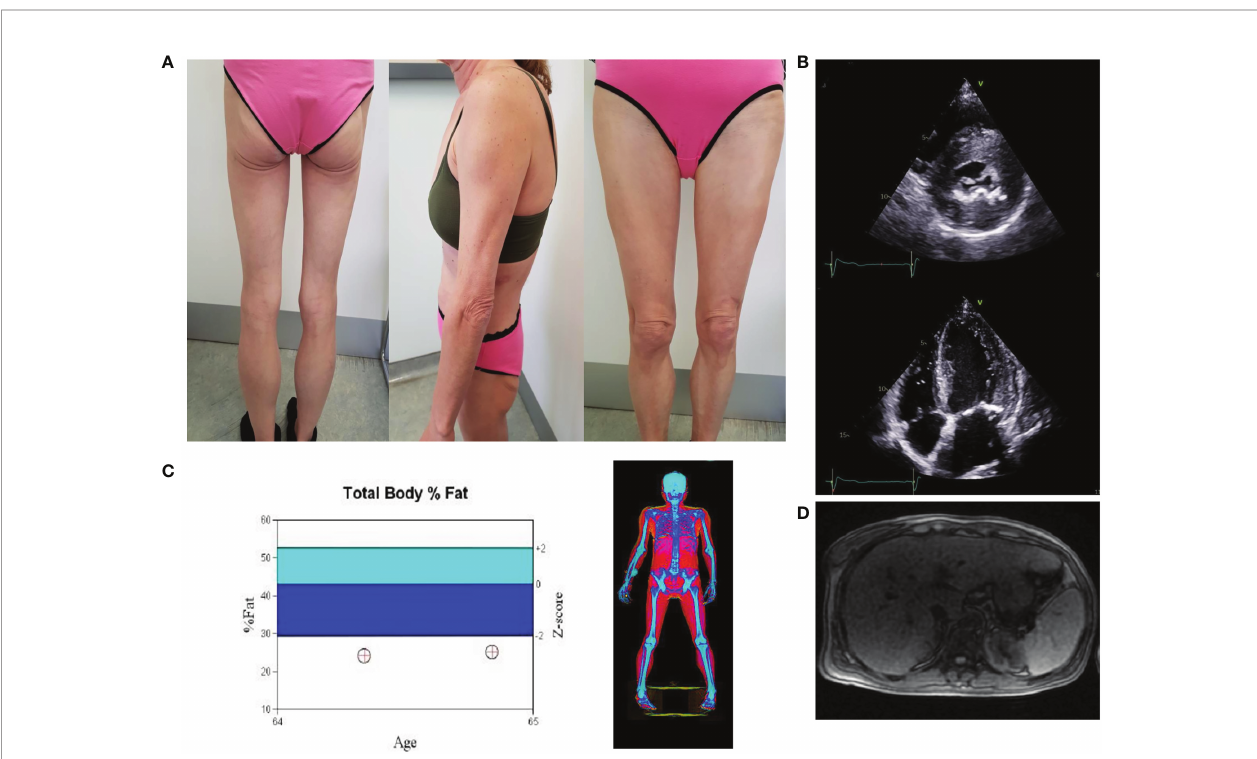
FIGURE 1 | (A) Total lipoatrophy of extremities and gluteal area, (B) Two dimensional echocardiography revealed left ventricular hypertrophy (interventricular septum thickness 20 mm), (C) DXA showed increased fat tissue of the abdominal region and decreased fat mass of the upper and lower limbs. Follow-up DXA indicated unchanged total fat mass content, (D) The abdominal MRI image shows hepatic